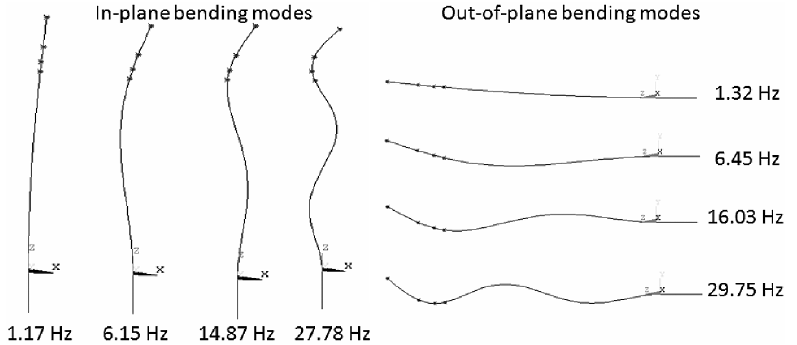
Fig. 6. First four vibration modes of the simplified concrete pole.